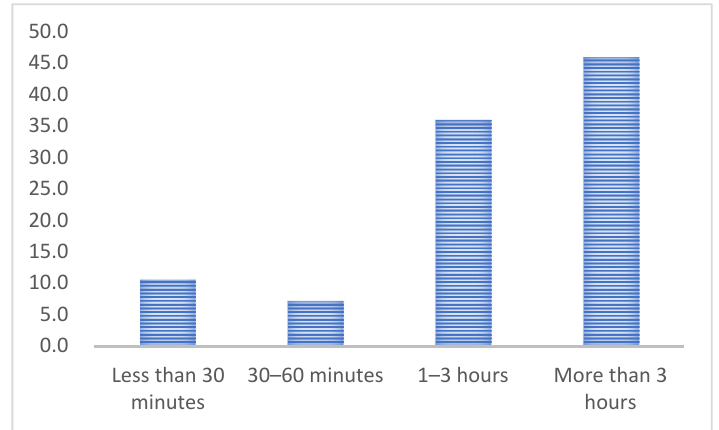
Figure 4. Visits’ length of sample distribution. Table 16. Hosmer and Lemeshow test results.